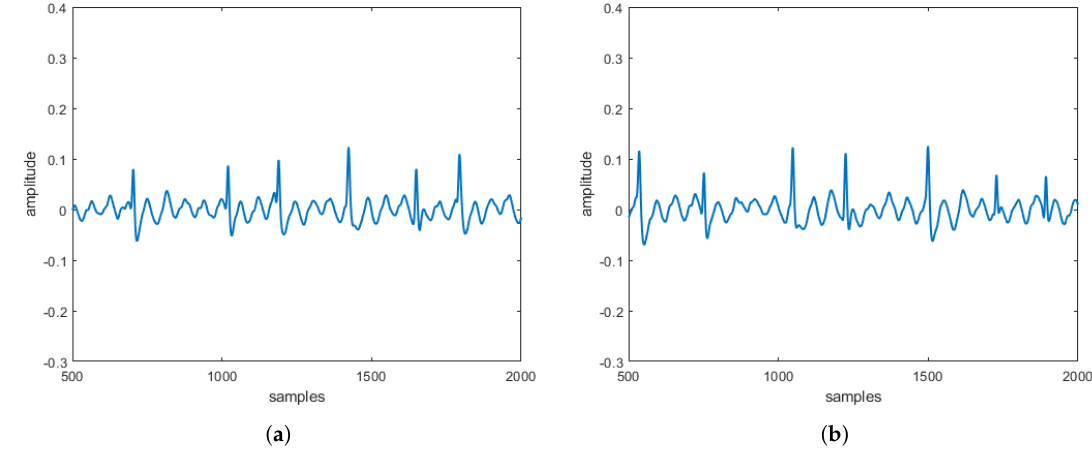
Figure 7. Case (a) of the proposed methodology: ( a ) atrial flutter and ( b ) typical ECG with atrial flutter.